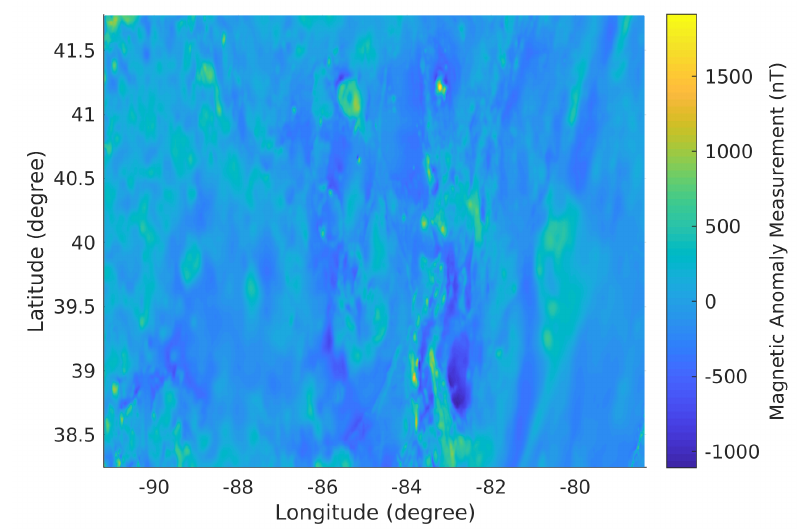
Figure 4. The magnetic anomaly map of the area around Columbus, Ohio, United State in geographic coordinate system at 305 m